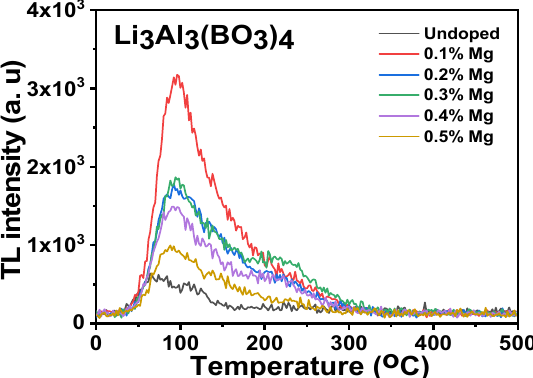
Figure 7. Undoped and Mg-doped lithium aluminum borate TL glow curves. The TL glow curve for the 0.1% mole Mg ‐ doped lithium aluminium borate was irra ‐ diated at 50 Gy after it was thermally cleaned and is shown in Figure 8. Thermal cleaning was done to eliminate the minor glow peaks that were present alongside the high temper ‐ ature region. The inset in Figure 8 represents the logarithmic glow curve plot which was used to identify supplementary peaks other than the foremost glow peak.